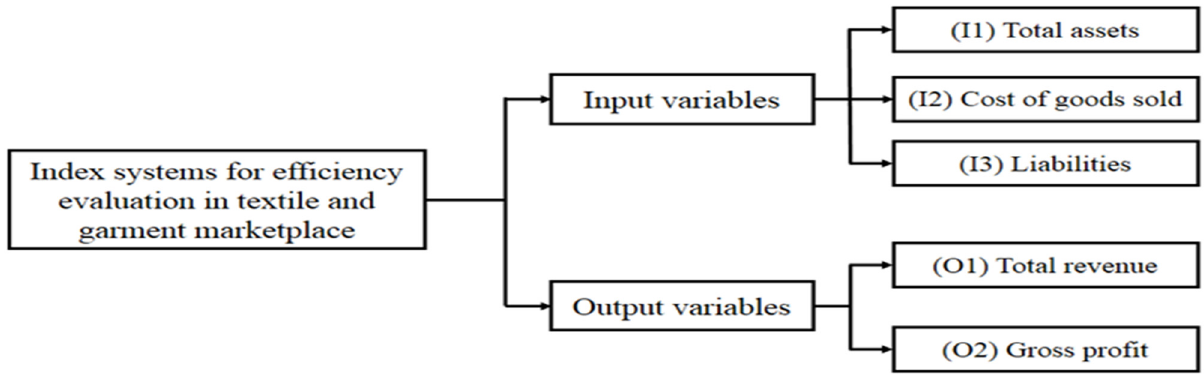
Figure 4. Selection of inputs and outputs.